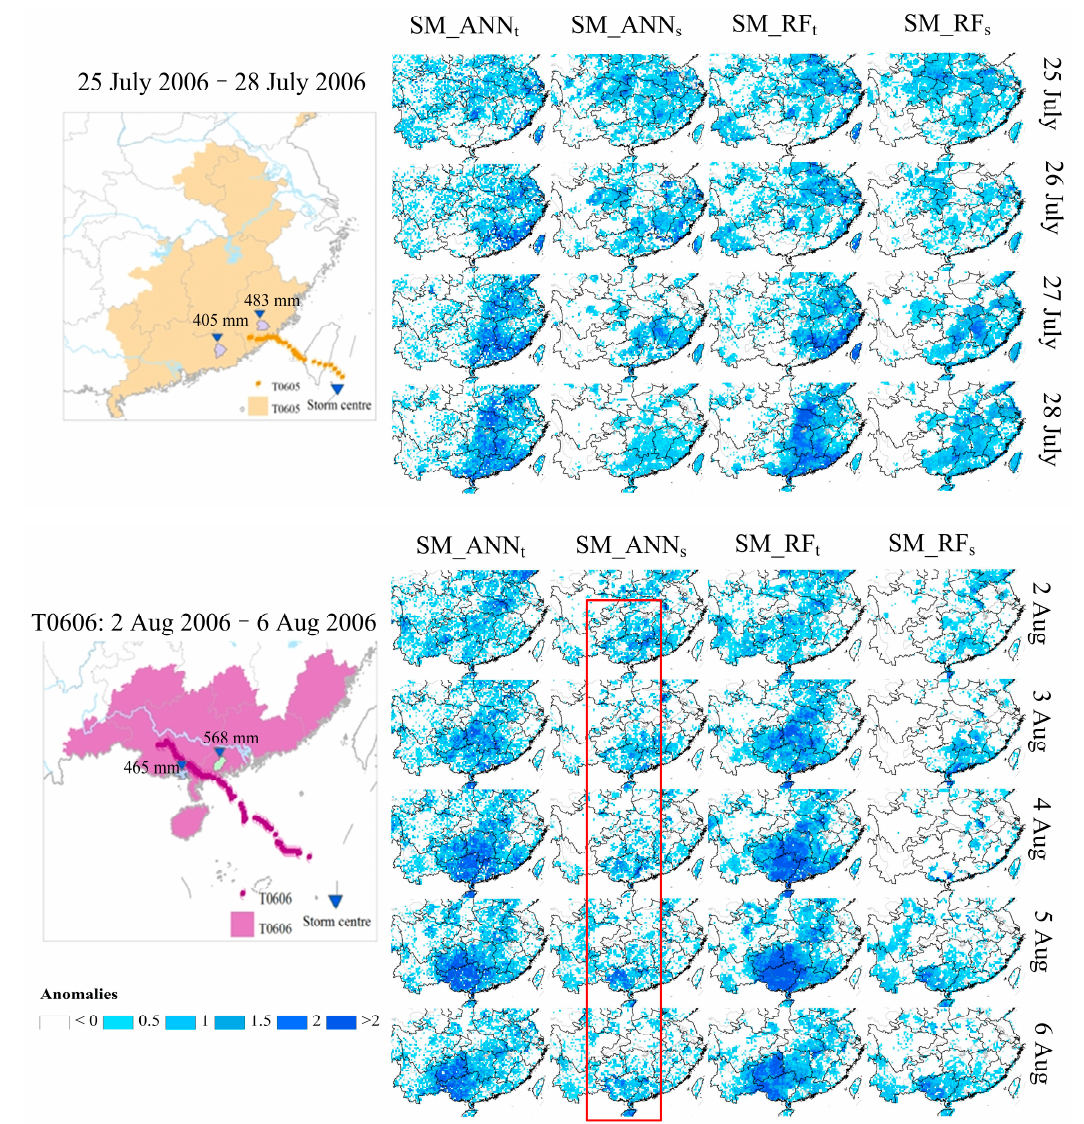
Figure 9. This is the same as Figure 8, but the fifth typhoon Kaemi (from 25 July to 28 July) and sixth typhoon Prapiroon (from 2 August 2006 to 6 August 2006) are displayed. The red solid rectangle shows the poor performances of SM_ANNs.